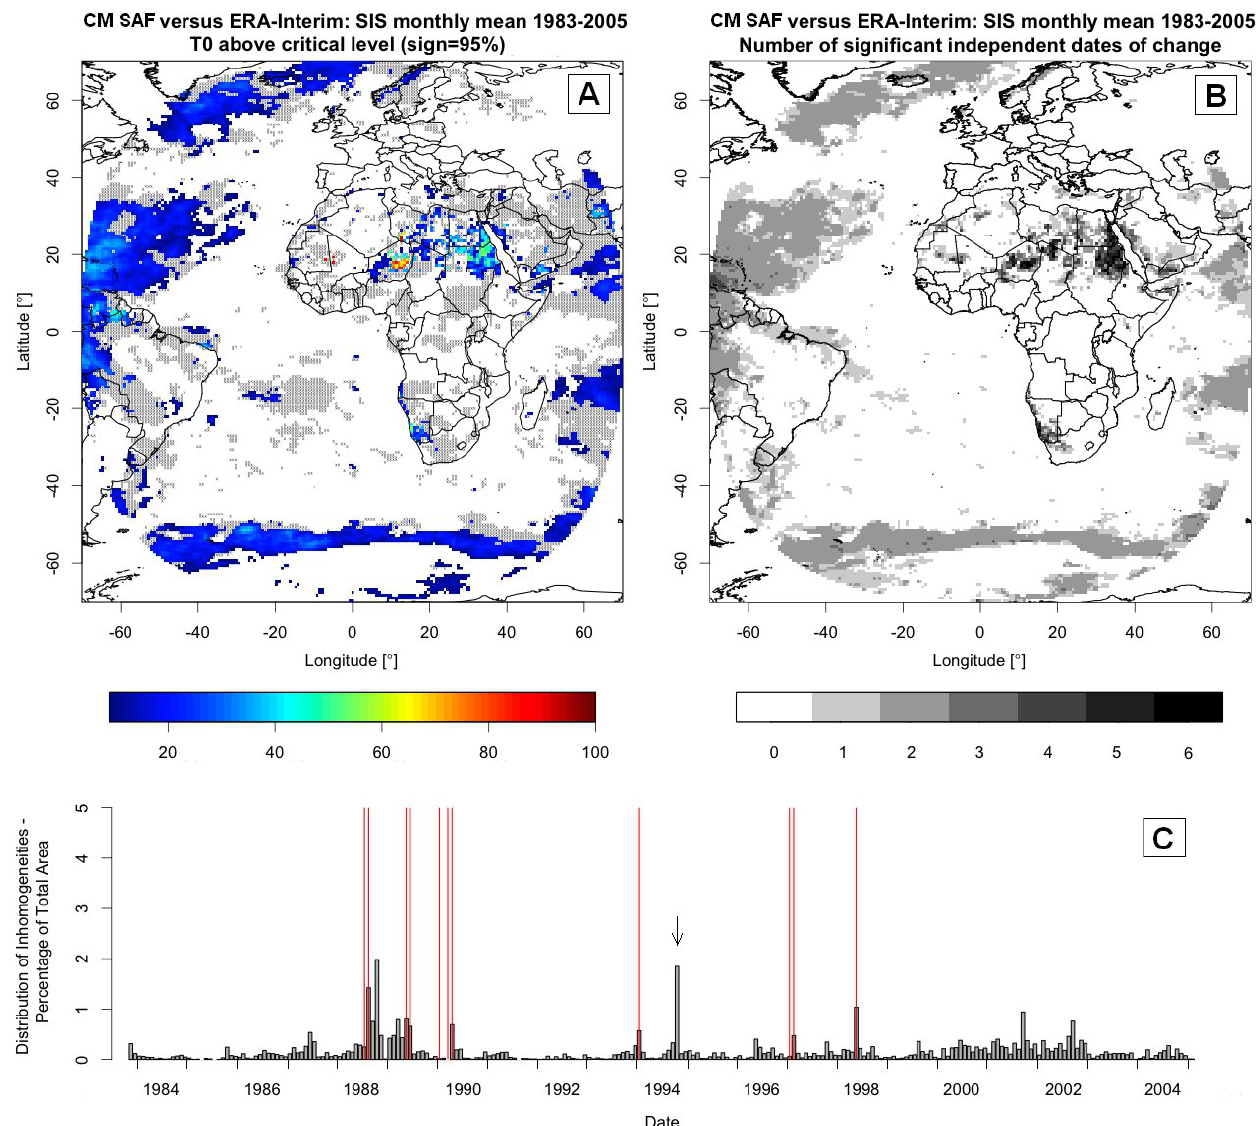
Figure 10. Same as in Figure 8, but for an analysis of detrended SIS series. ( A ) T above a significance level of 95% for CM SAF SIS data (grey shaded areas mark the filtered regions); ( B ) number of detected inhomogeneities; and ( C ) distribution of the frequency of breaks (in percent of total area). Satellite changes are indicated by vertical lines. The arrow marks the date of a retrieval